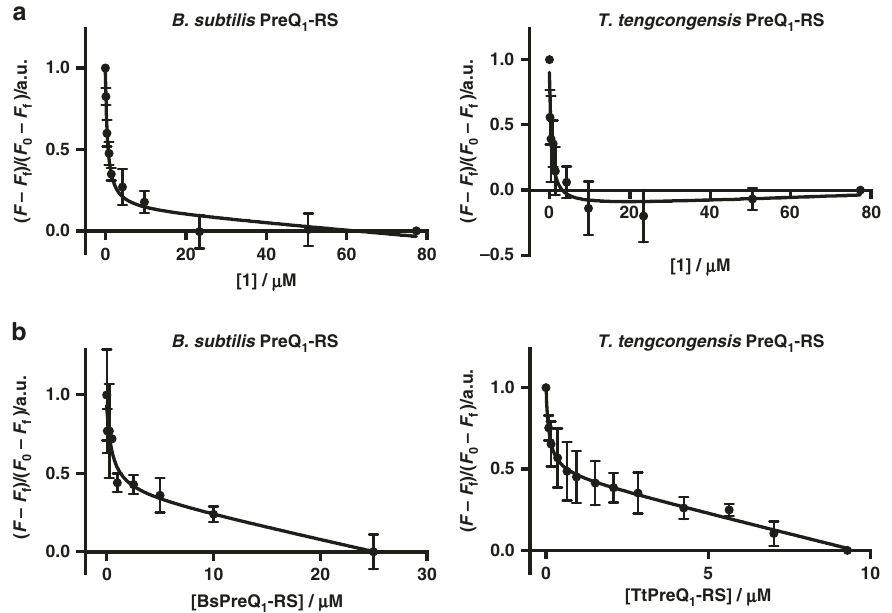
Fig. 3 Af fi nity of 1 for PreQ 1 -RS aptamers. a Fluorescence intensity assay of 5 ′ -Cy5-labeled Bs PreQ 1 -RS or 5 ′ -AlexaFluor 647-labeled Tt PreQ 1 -RS RNA in the presence of increasing concentration of 1 . b Inherent fl uorescence titration of 1 with increasing concentration of unlabeled Bs PreQ 1 -RS or Tt PreQ 1 -RS RNA. Error bars indicate the standard deviation determined from three independent measurements. Source data are provided as a Source Data fi